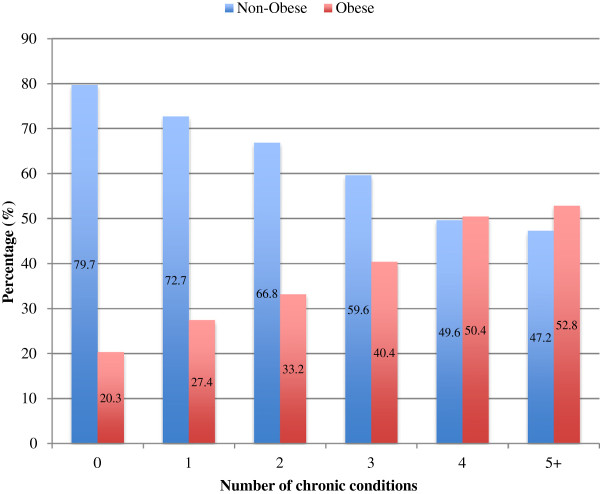
The prevalence of obesity increases with increasing number of chronic conditions (Obesity was not included in the number of chronic conditions).